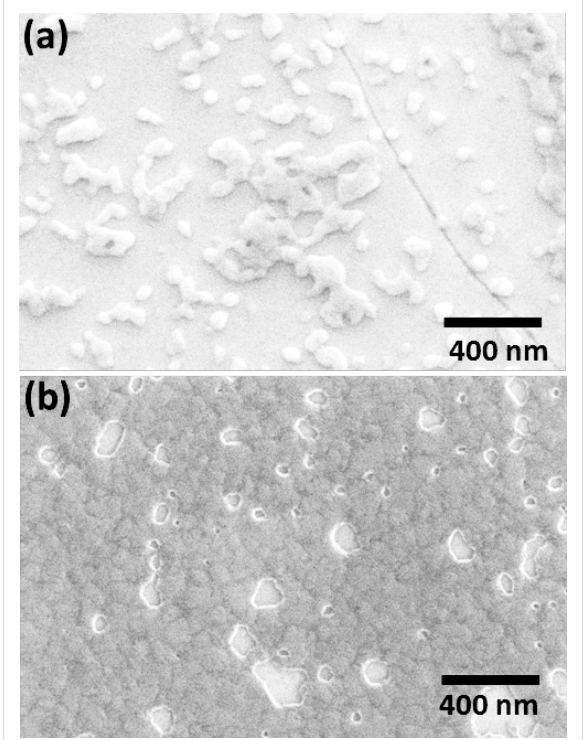
Figure 5: SEM images of Cu nucleation and growth on a MBP0-SAM on Au/Ag/Mica prepared at 65 °C for 24 h. (a) Cu nucleation sites and islands after deposition at − 0.7 V for 1 s. (b) Cu layer after nucleation at − 0.7 V for 1 s and growth at − 0.35 V for 5